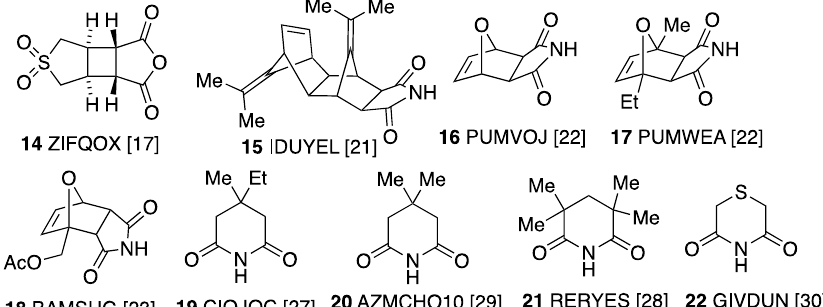
Figure 3. ( a ) Molecular structure of 1 with numbering system used (50% thermal ellipsoids), ( b ) hydrogen bonding pattern for 1 . Table 4. Hydrogen bonding parameters (Å, ° ).